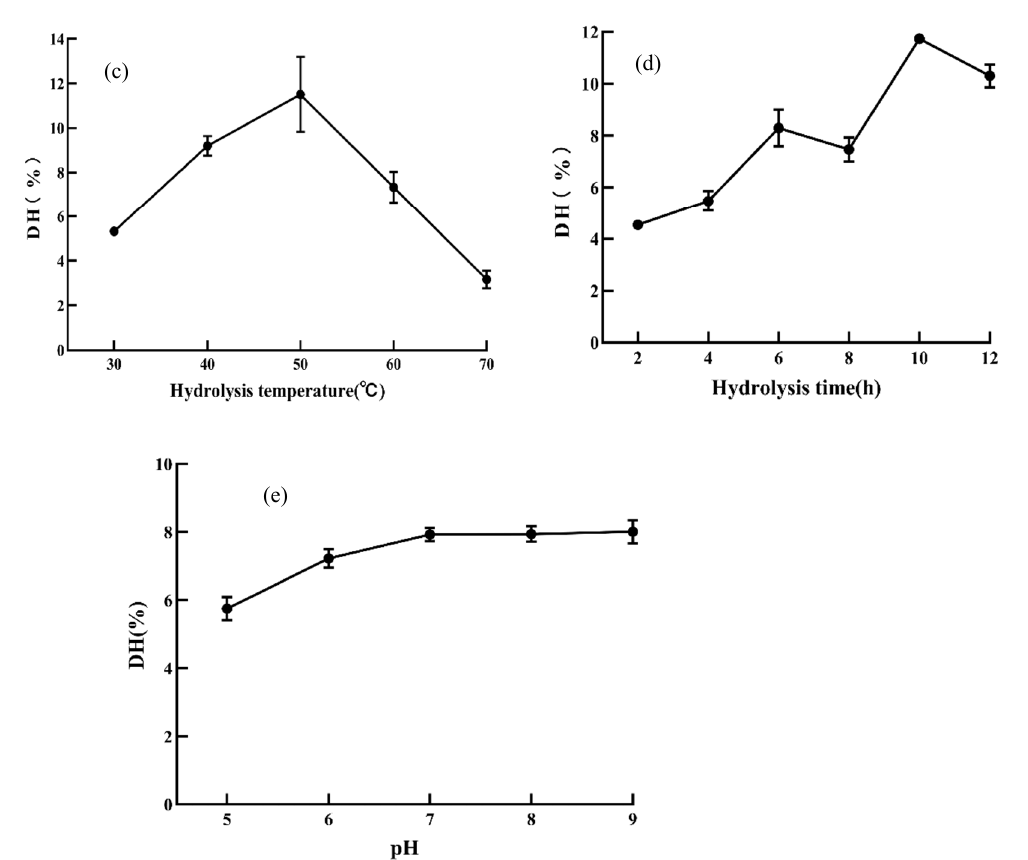
Figure 2. Effects of five single factors on DH of EBNH. ( a ) Water/material ratio ( v/w ); ( b ) enzyme concentration (U/g); ( c ) hydrolysis temperature (°C); ( d ) hydrolysis time (h); ( e ) pH; DH represents the degree of hydrolysis. Data indicated as means ± SD ( n = 3).